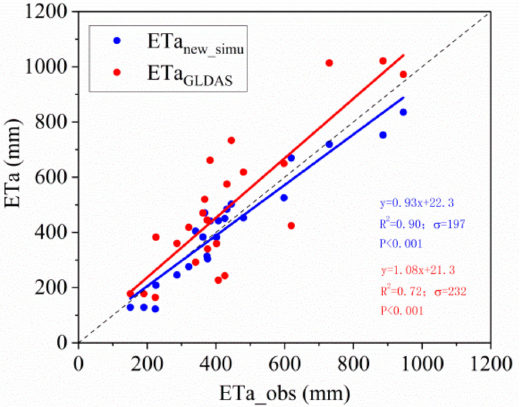
Figure 4. Comparison of the improved ET a values (ET anew_simu ) with the observed and GLDAS ET a